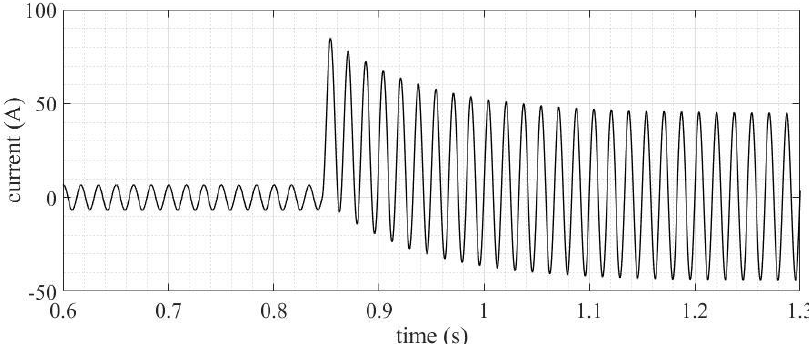
Figure 9. Three-phase fault current — phase A — without SV manipulation condition.